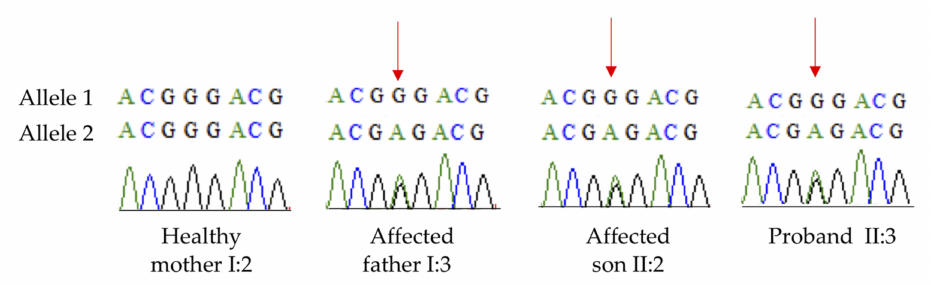
Figure 2. Family pedigree of CRYBB3 patients with two generations depicted. Black circles and squares indicate individuals affected by pediatric cataract and microphthalmia. N/A—data not available.